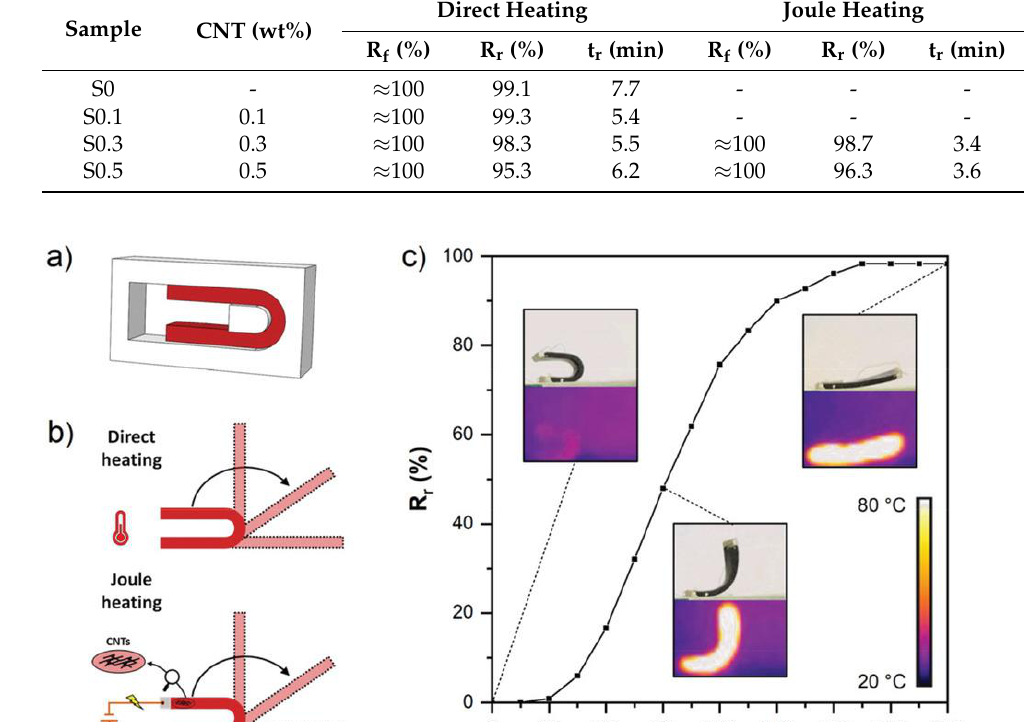
Table 3. Shape memory properties of the DLP-printed nanocomposites (table reproduced from [139]). Sample